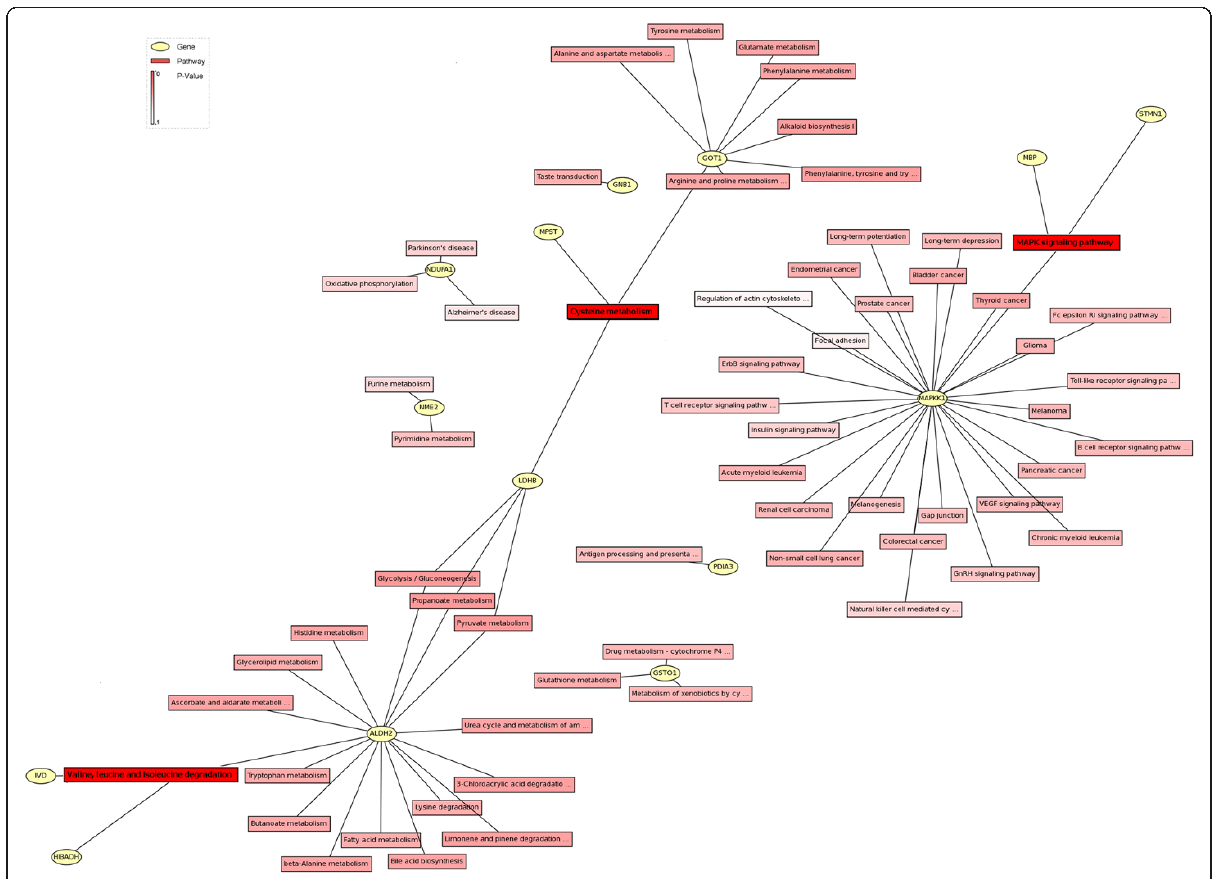
Figure 5 Protein networks of hippocampal differentially expressed